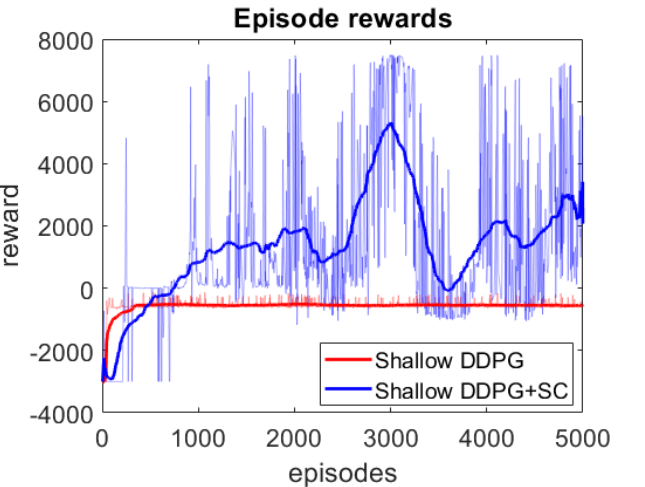
Figure 5. Episode rewards during DDPG training of shallow models. Darker lines represent the moving average reward plot, whilst the actual reward values are seen in the transparent